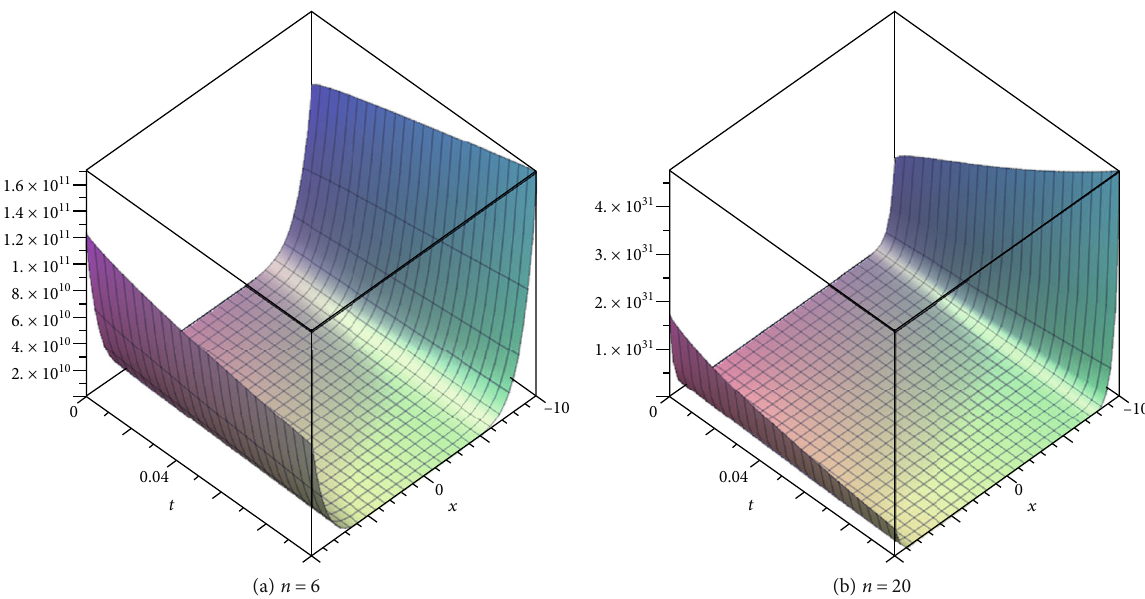
x , t Þ for Eq.(3) when a 2 ð